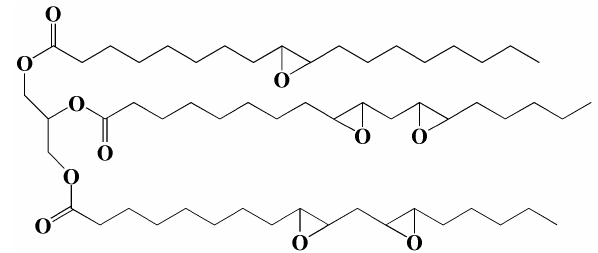
Figure 1. Chemical structure of epoxidized soybean oil.